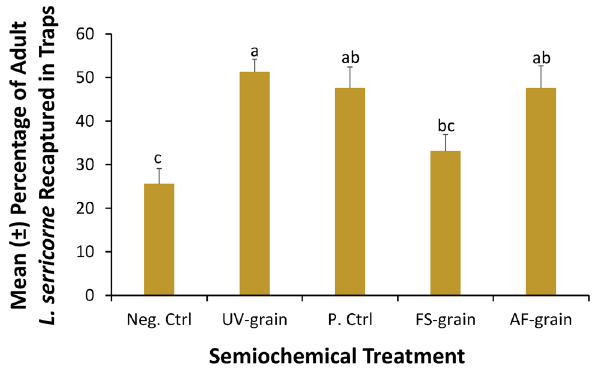
Figure 5. The mean percentage of adult L. serricorne recaptured in the release-recapture assay in response to MVOCs and grain used as lures in commercially-available monitoring pitfall traps, with a total of 20 adult, mixed-sex L. serricorne released in large plastic bins and placed in a large, walk-in environmental chamber under constant abiotic conditions and given 24 h to respond at the USDA-ARS Center for Grain and Animal Health Research in Manhattan, KS for a total of n = 8 replicate releases per treatment. Bars with shared letters are not significantly different from each other (Tukey HSD, α =